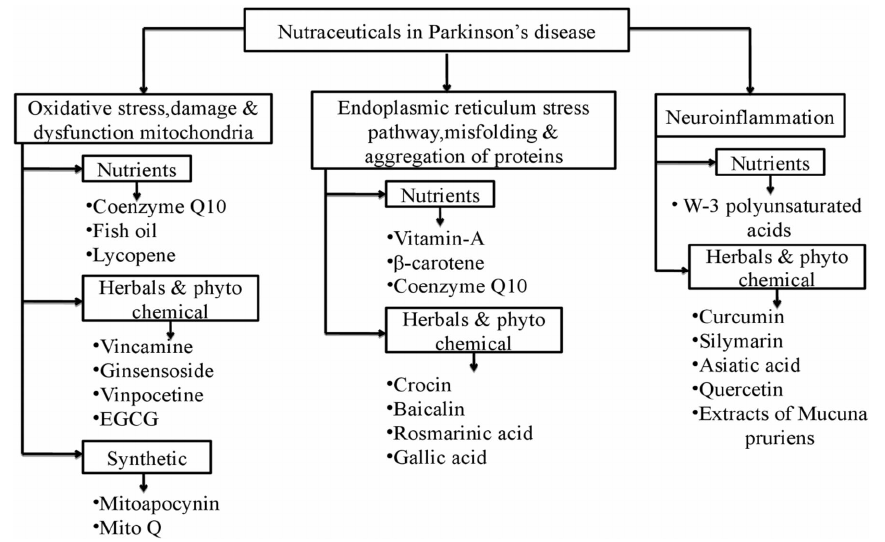
Figure 3. Nutraceuticals in Parkinson’s disease act by three pathways. 1. By preventing oxidative stress, which leads to protection of mitochondria from further damage and dysfunction and ultimately maintains energy homeostasis and cellular metabolism; 2. Activation of misfolded proteins and their aggregation induces stress in endoplasmic reticulum (ER), which further causes autophagy and degradation of neuronal proteins. 3. Inflammation in neuronal cells is the main cause of neurodegeneration and onset of Parkinson’s disease